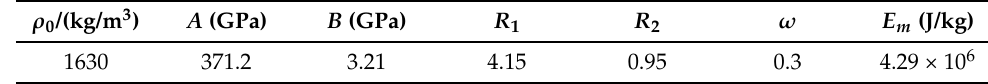
Table 1. TNT explosive parameters.